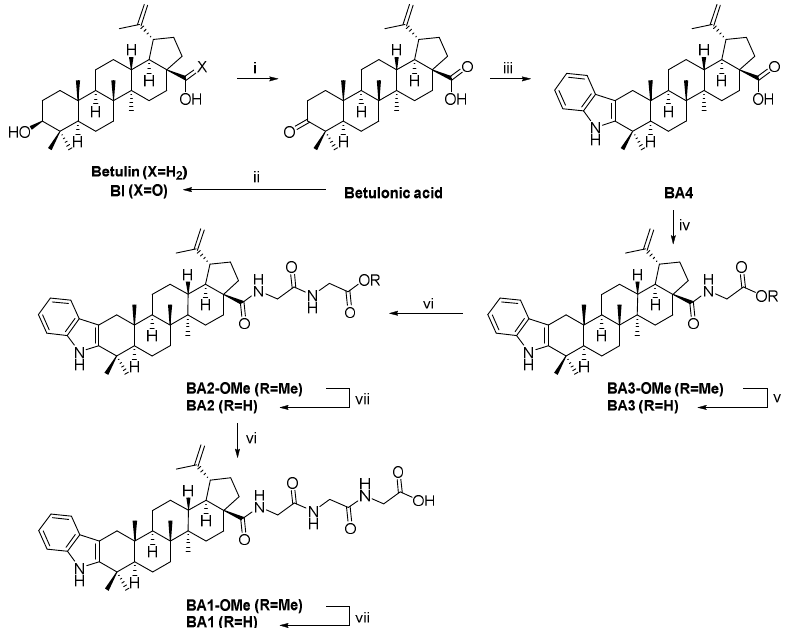
Figure 1. Synthetic route for the preparation of triterpenoid derivatives. Reagents and conditions: (i): Khlebnicova 2017; (ii): Levdanskii 2015; (iii): Khusnutdinova 2019; (iv): Kumar 2008; (v): Mukher- jee 2008; (vi): acid, EDC·HCl, HOBt, DIPEA, HCl·H-Gly-OMe, DCM, RT, 24 h; (vii): ester, NaOH, H 2 O/MeOH, 45 °C, 2 h.